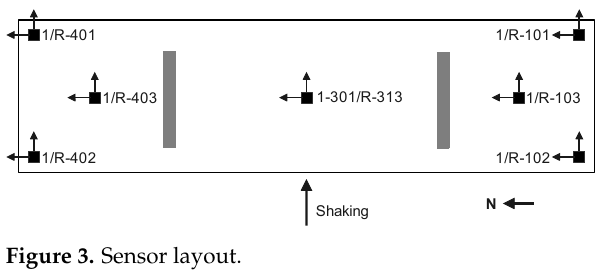
Figure 3. Sensor